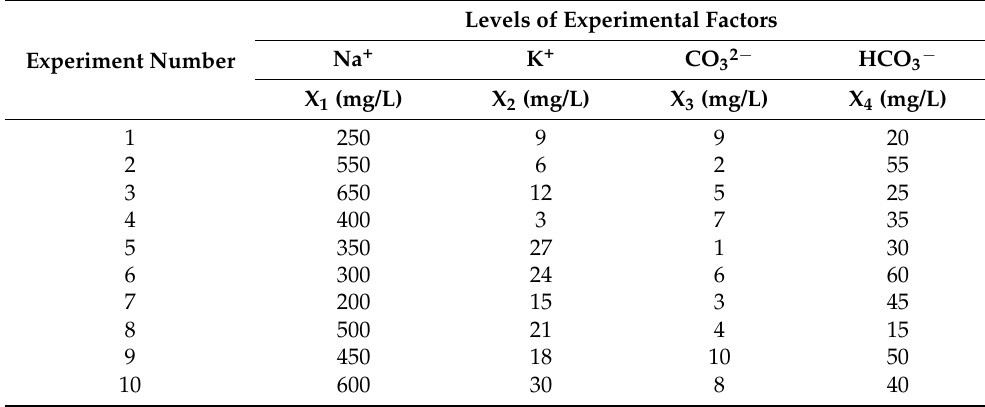
Experiment Number